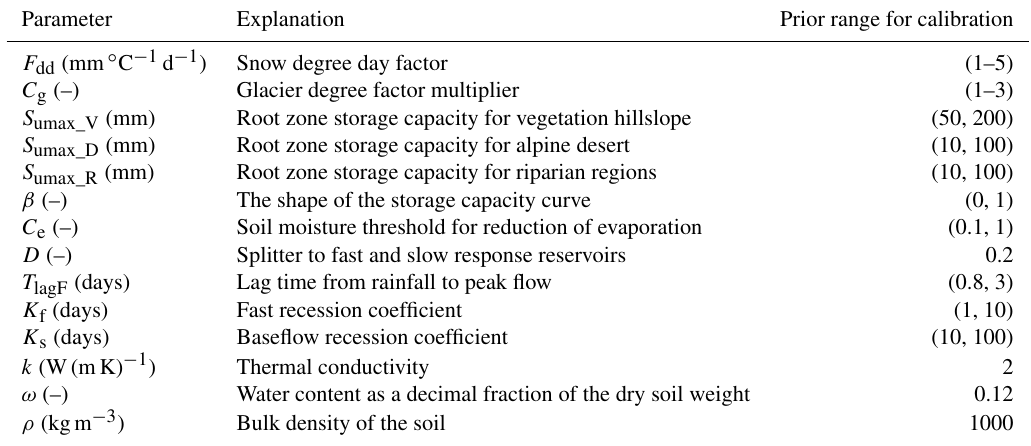
Table 2. The parameters of the FLEX-Topo-FS model and their prior ranges for calibration.